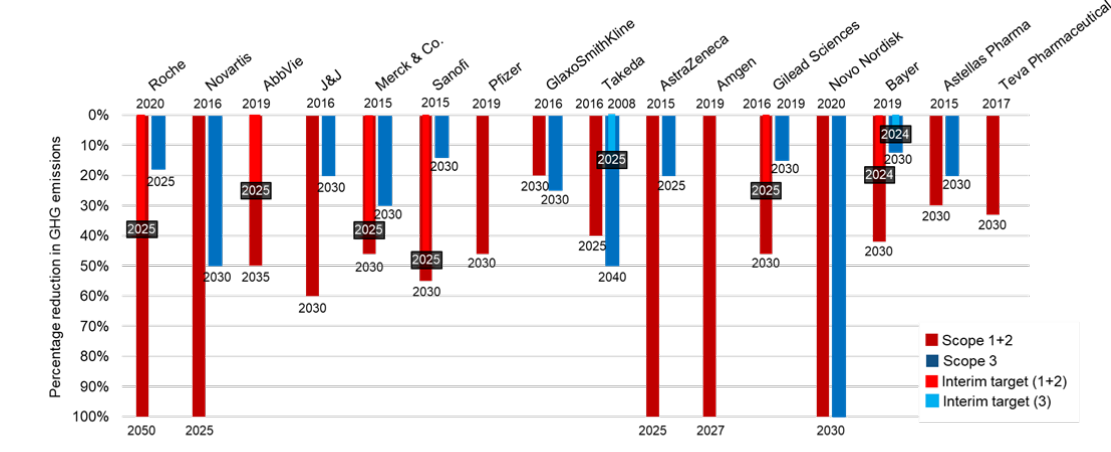
Figure 1. Commitments to percentage greenhouse gas (GHG) emission reduction in scope 1, 2, and 3 emissions by a range of target years by 16 pharmaceutical companies that made them.